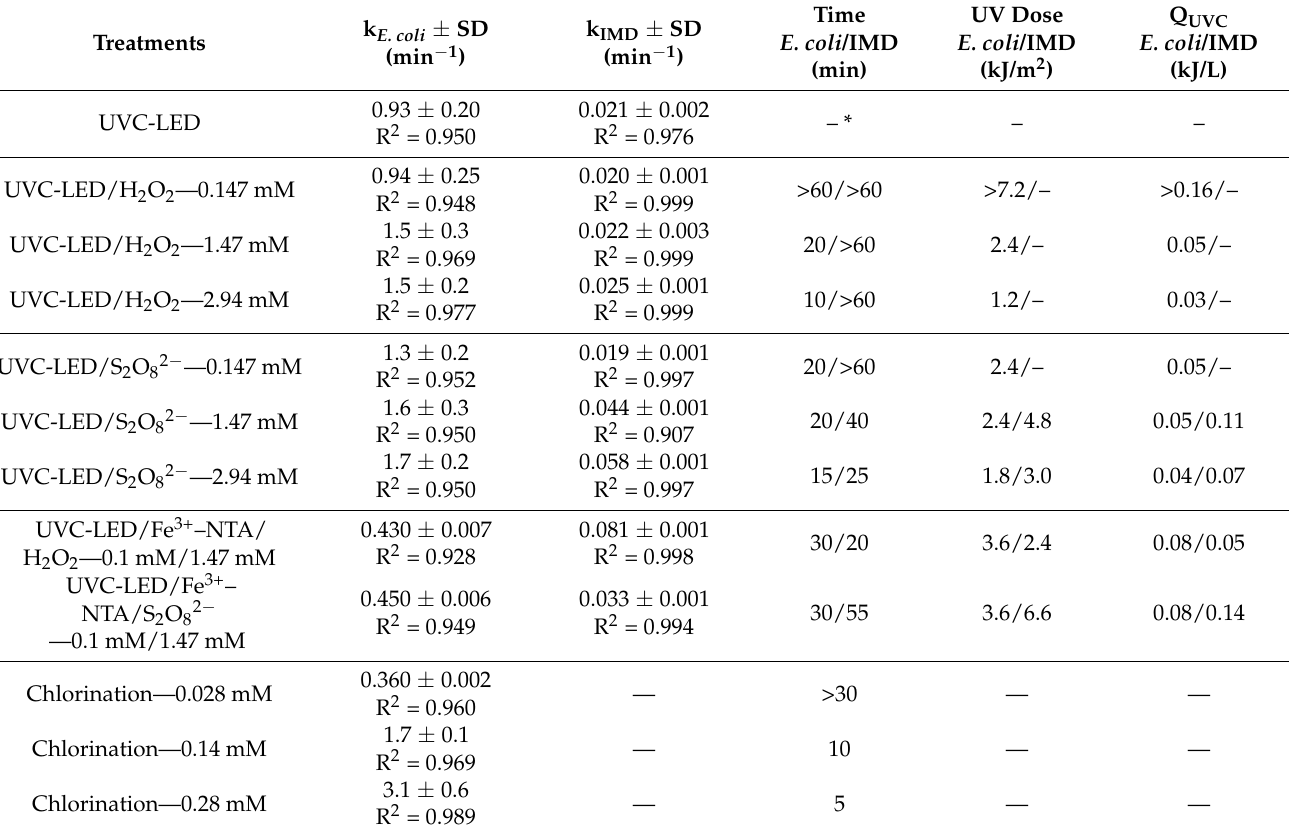
Table 1. Pseudo-first-order kinetic constants of E. coli inactivation and IMD removal, dose, accumulate energy, and disinfection/decontamination time for complete E. coli inactivation and more than 80% IMD removal for all treatments discussed in this